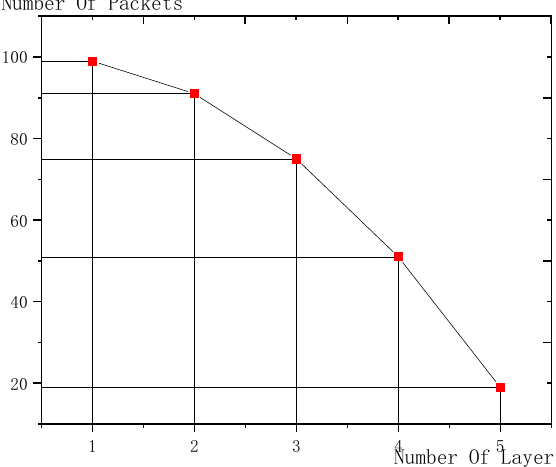
Figure 9. Comparison of the packets forwarded by each layer ( n = 100, R = 100, r = 10).